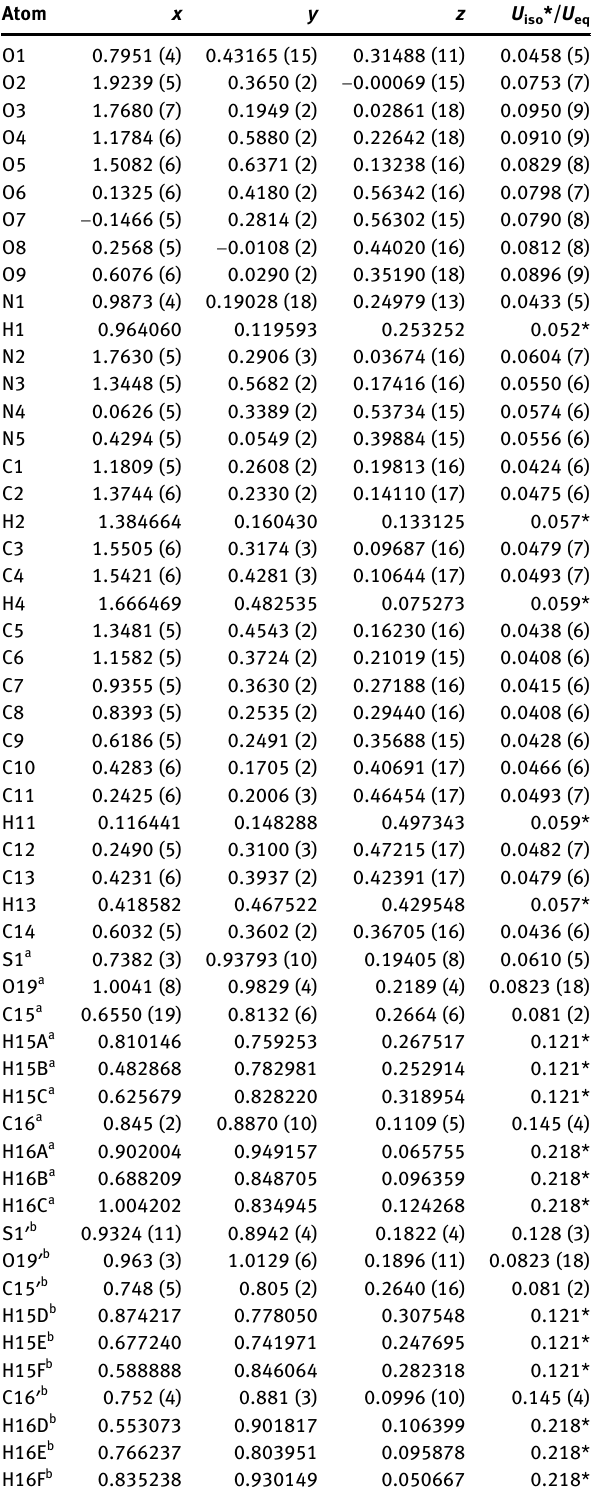
Table  : Fractional atomic coordinates and isotropic or equivalent isotropic displacement parameters (Å 